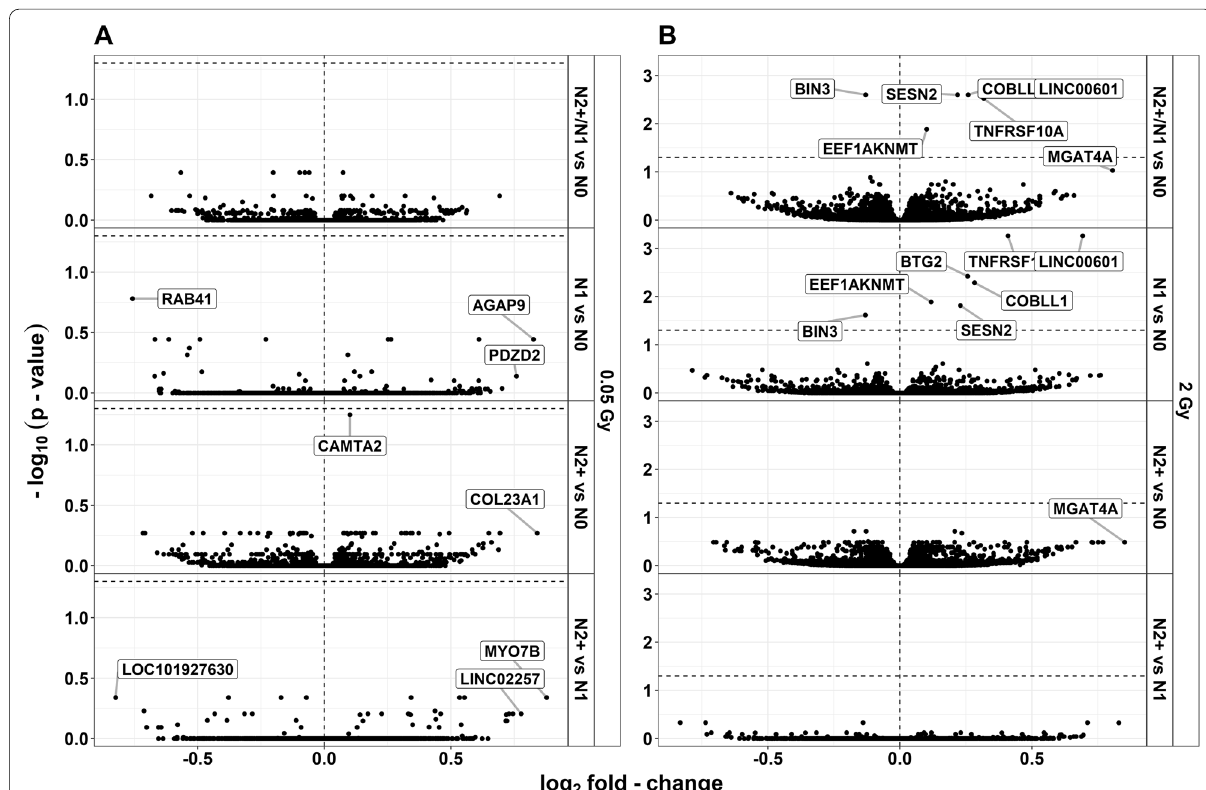
Fig. 3 Summarized results on interaction effects. Results of analysis for differentially expressed genes in irradiated compared to sham‑irradiated fibroblasts from donors with a first primary neoplasm only (N1), donors with at least one second primary neoplasm (N2 (N0) 4 h after exposure to A 0.05 Gray and B 2 Gray including the interaction of group status and radiation dose. The data are presented for model 1 (considering age at sampling and sex). The highlighted genes were selected based on the data structure of each comparison, to highlight top‑ranking genes: if their p ‑value was among the top 0.01% of that data set, p‑value < 0.15, and/or log 2 fold‑change> |0.75|. Dashed horizontal lines indicate the significance threshold of the adjusted p ‑value <